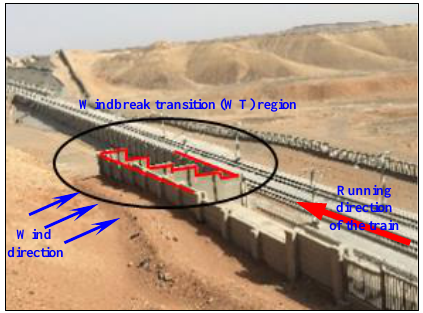
Figure 1. WT region on an actual high-speed railway.